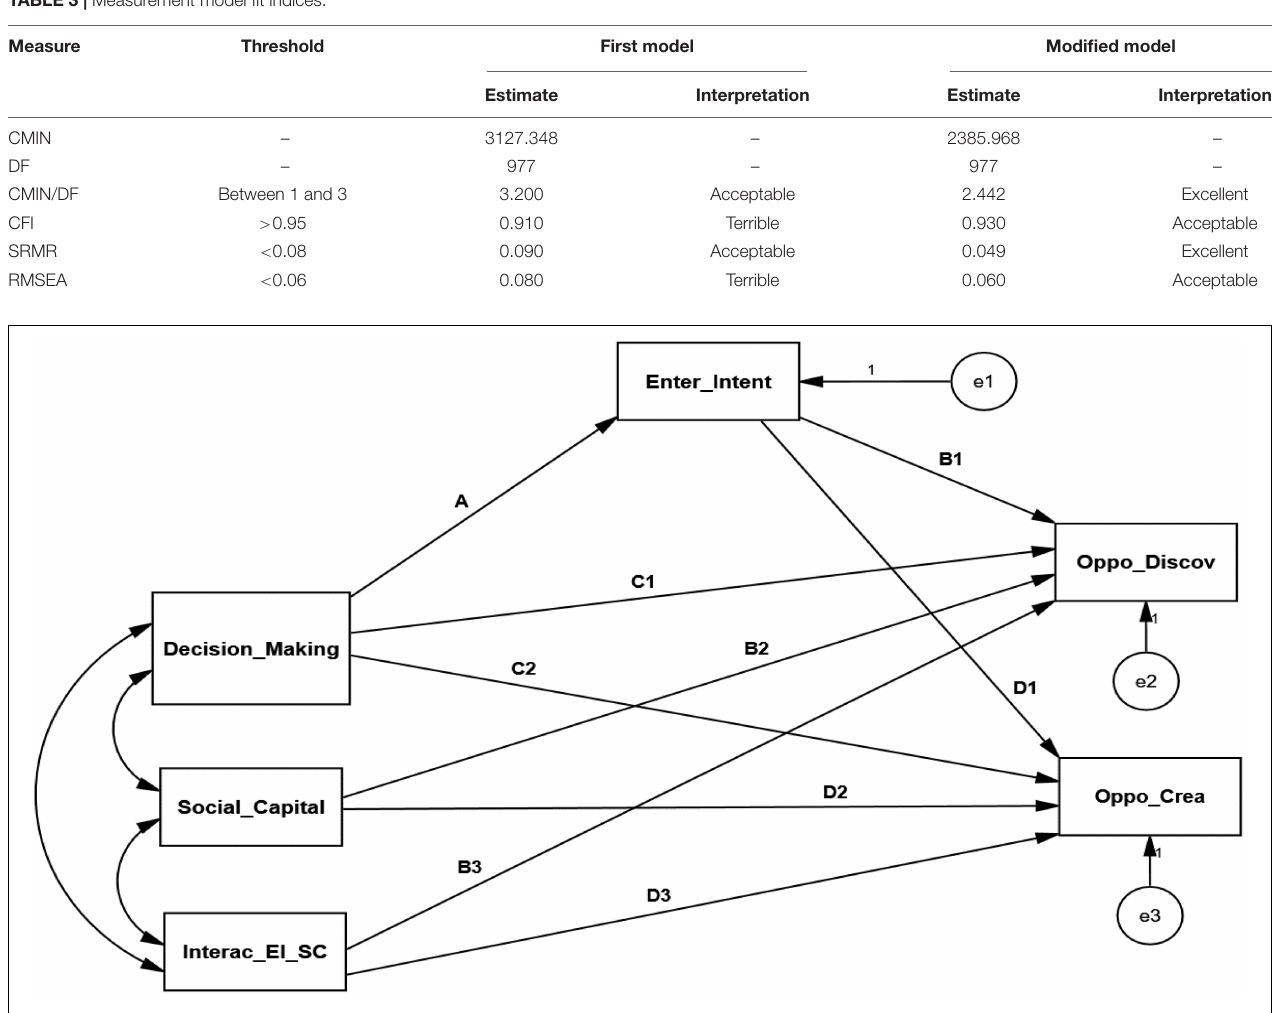
TABLE 3 | Measurement model fit indices.